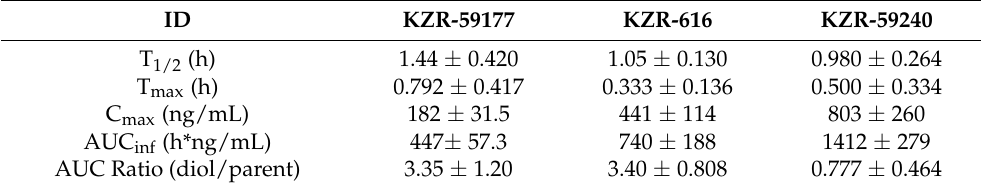
Table 3. PK parameters of KZR-616 and analogs after a single SC dose of 3 mg/kg in